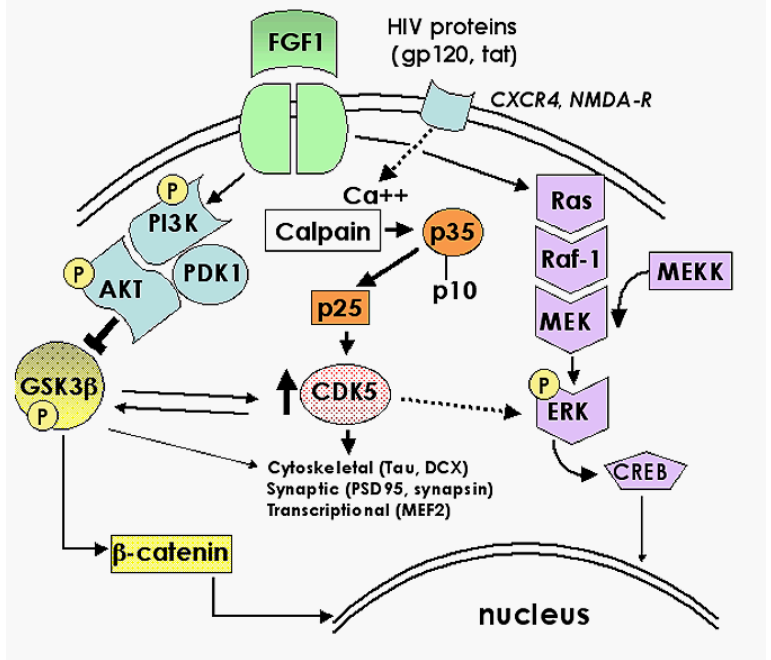
Figure 7. Schematic diagram showing the role of the GSK3  and CDK5 signaling pathways in mediating the toxic effects of HIV proteins. HIV proteins and cellular neurotoxins might stimulate the GSK3  and CDK5 signaling pathways via receptor interactions, resulting in the downstream disruption of processes involved in regulating synaptic and neuronal integrity. Growth factors such as FGF1, or other inhibitors of GSK3  signaling, might ameliorate these effects by antagonizing the activation of GSK3  by HIV proteins and cellular neurotoxins. GSK3  and CDK5 share several downstream targets (e.g. Tau), and simultaneous activation of both of these pathways may exacerbate the neurotoxic effects of HIV